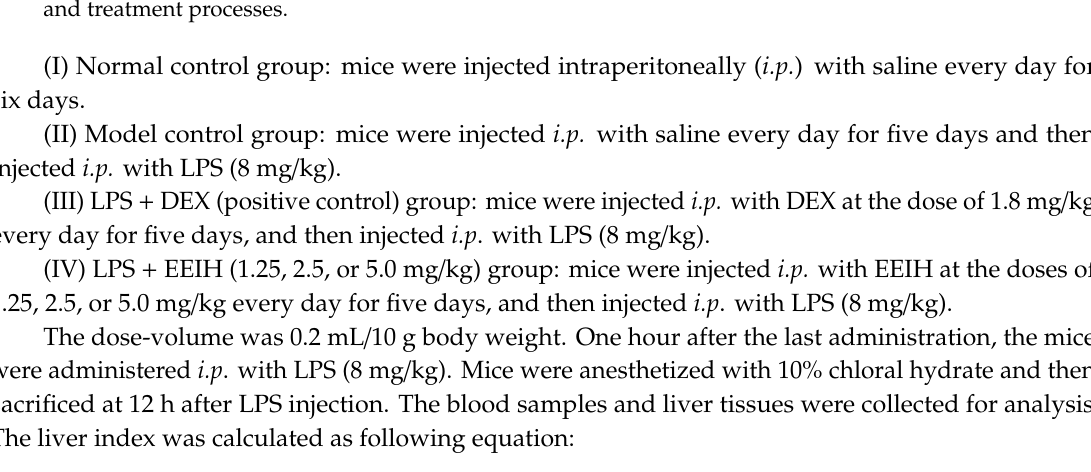
Figure 1. Experimental protocol for lipopolysaccharide (LPS)-induced acute liver injury (ALI) model and treatment processes.